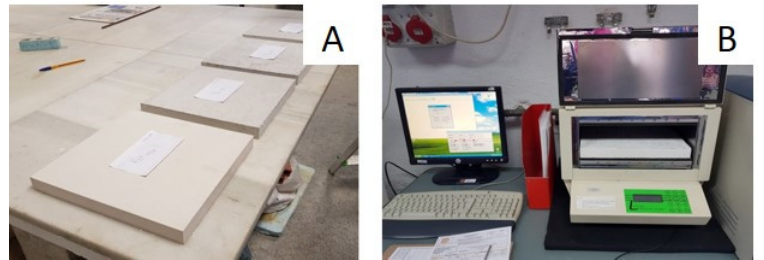
Figure 5. Thermal conductivity test: ( A ) The boards prepared for testing; and ( B ) board with PR during test.